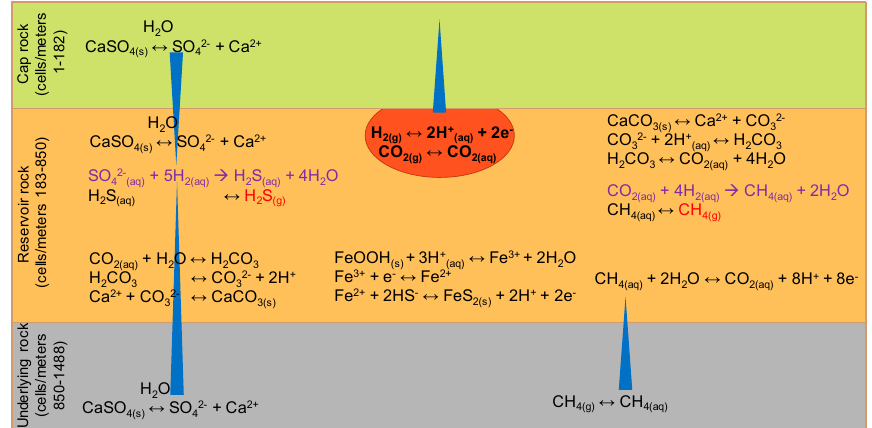
Figure 1. Selected reactions and processes associated with bacterial sulfate reduction and methanogenesis (purple). Single arrow = kinetic-controlled reactions; double arrow = equilibrium reactions; blue triangles = time-dependent diffusive transport of aqueous components; bold = injected gas for storage.